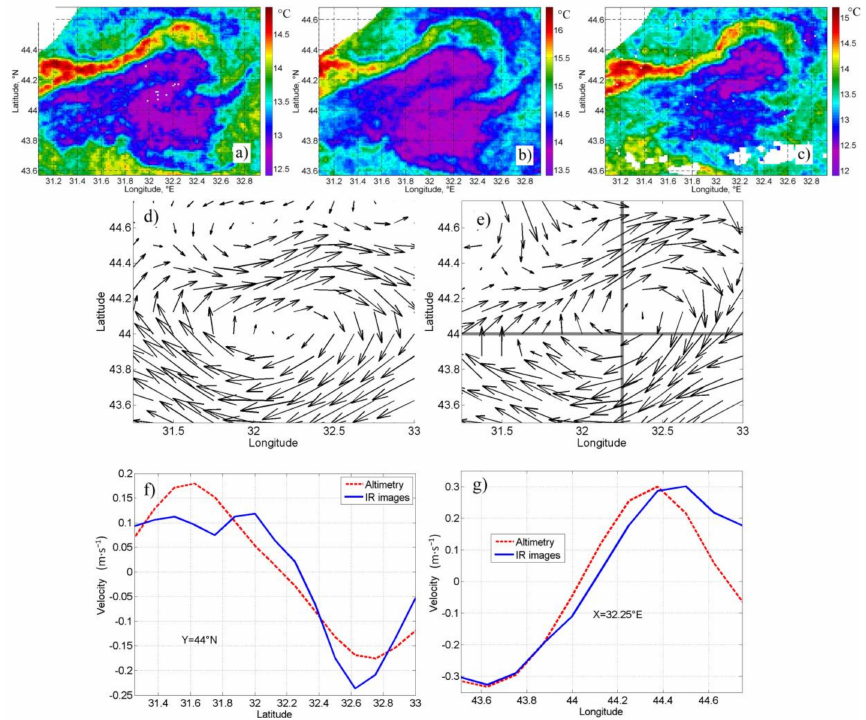
Figure 1. ( a – c ) AVHHR SST in the vicinity of the Sevastopol anticyclone on 13 May 2005 09:11 ( a ), 13 May 2005 13:55 ( b ), 14 May 2005 00:34 ( c ); ( d , e ) Surface current calculated for 13 May 2005 from altimetry ( d ), from IR images (solid line—sections) ( e ); ( f , g ) meridional section of u ( f ), zonal section of v ( g ) (red line—altimetry; blue—IR images). Velocity fields calculated from satellite altimetry and 4D-Var assimilation of AVHHR imagery are shown in Figure 1d,e. Both methods are able to reconstruct the observed anticyclone and its asymmetry. Velocity distribution is also asymmetric, with maximums in the northwest and southeast parts of the eddy. A comparison of meridional sections of zonal velocity (vx) and zonal sections of meridional velocity (vy) across the eddy center (gray lines on Figure 1e) is shown in Figure 1f,g. Amplitudes of meridional velocity obtained by the two methods are almost equal; the maximum, − 0.3 m · s − 1 , is situated near the periphery of the eddy (on about 2/3 radius length). Zonal velocities are slightly biased: They vary from − 0.25 m · s − 1 to 0.1 m · s − 1 for image sequences and from − 0.17 m · s − 1 to 0.17 m · s − 1 for altimetry data. This bias is related to the small differences in the orientation of the anticyclone, computed from two methods. The anticyclone in altimetry data (Figure 1a) is elongated in the west–east direction. At the same time, from the satellite images in Figure 1a–c it can be seen that the eddy is stretched more in the northeast–southwest direction. This corresponds with the results obtained used 4D-Var assimilation (Figure 1e). Therefore, in this case it can be suggested that the eddy form is slightly distorted in altimetry data. This can be related to the mapping procedure and spatial and temporal interpolation of along-track data, which lead to additional smoothing of dynamic topography [71]. Another probable reason is the inaccuracy in MDT, which is hard to obtain precisely near the abrupt continental